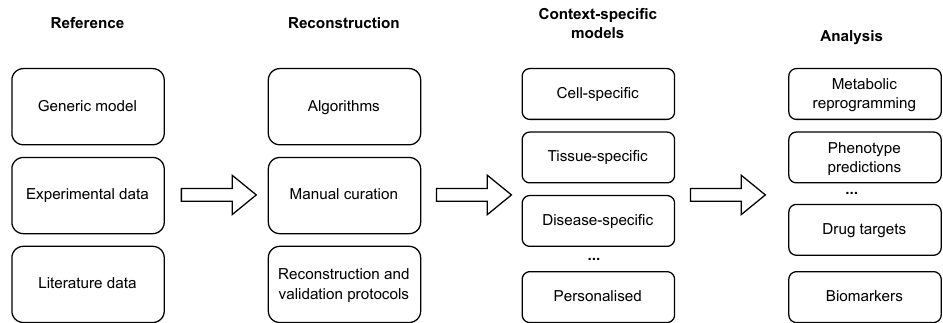
Figure 1. Reconstruction and analysis of context-specific GEMs. Generic models are tailored to a specific context with the integration of (high-throughput) experimental and literature data using a combination of automated algorithms and manual curation. The reconstruction process can be additionally enhanced with the application of reconstruction and validation protocols. The reconstructed models can be used to conduct different analyses, ranging from the prediction of phenotypes and context-specific reprogramming of a metabolic network to the identification of drug targets and disease